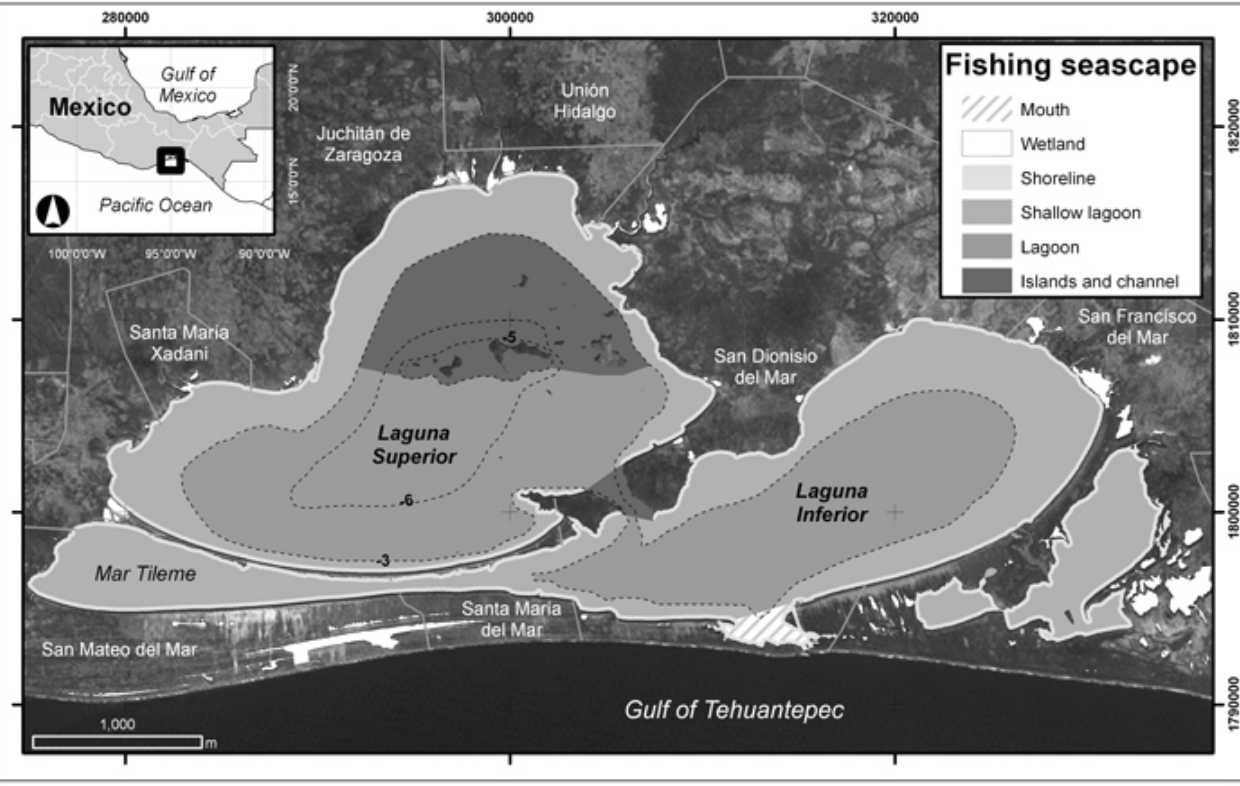
Fig. 5 . Huave Lagoon System regionalization according to seasonal variations of fisheries resources. The percentage cover of each fishing seascape was: shallow lagoon = 39.3%, lagoon = 38.4%, islands and channel = 10.4%, shoreline = 7.7%, wetlands = 3.6%, mouth =